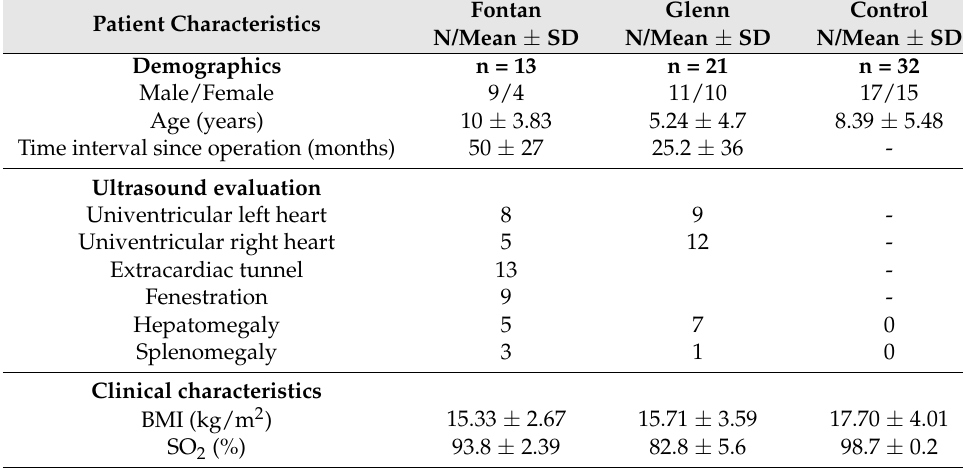
Table 1. Clinical characteristics of the